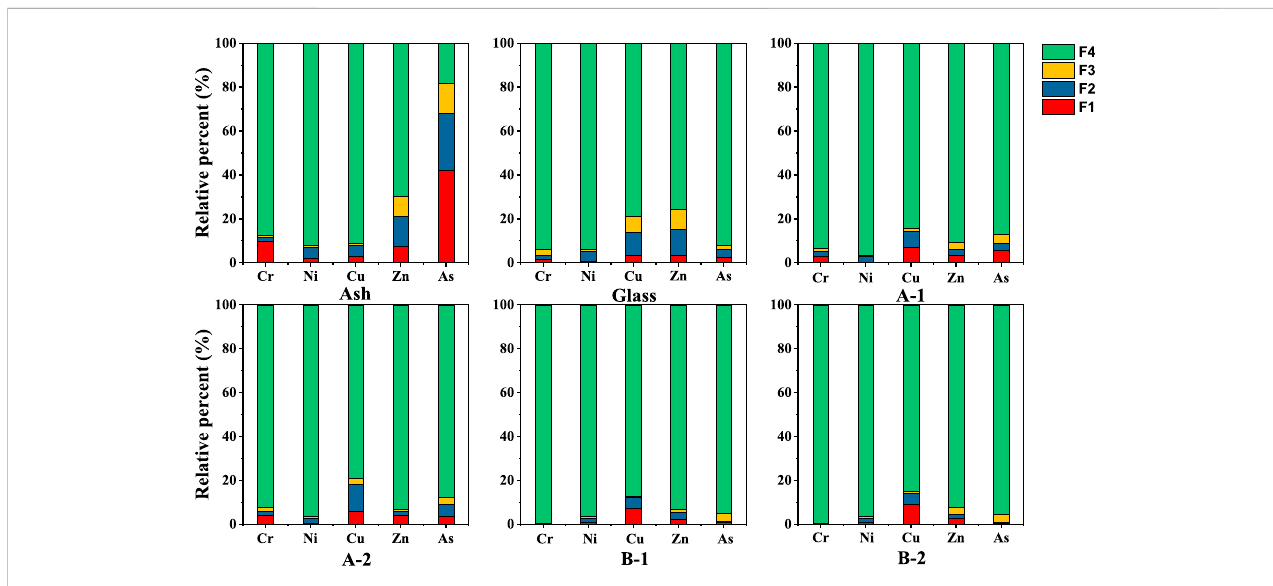
FIGURE 6 Chemical speciation distributions of heavy metals in glass and ceramics-glass. A-1: sintered at 850 ° C for 1 h, A-2: sintered at 850 ° C for 2 h, B-1: sintered at 1,050 ° C for 1 h, B-2 is sintered at 1,050 ° C for 2